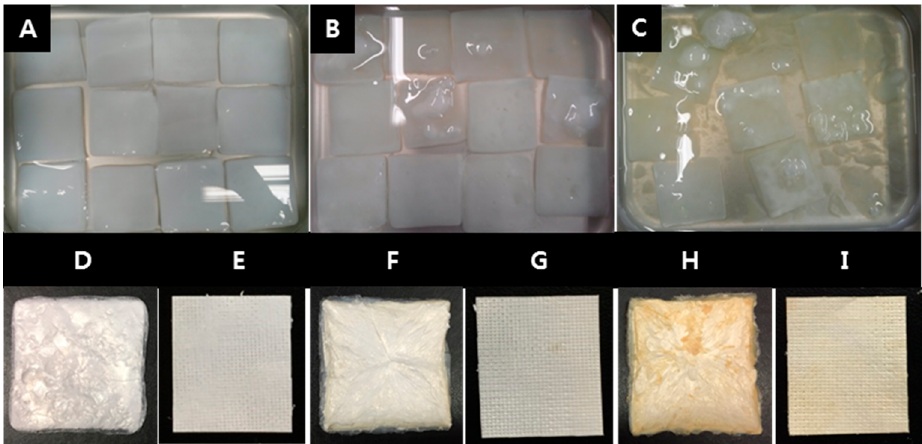
Figure 14. Bacterial cellulose (BC) pellicles were irradiated in distilled water by Electron beam linear accelerator ( A : NI-BCMs, B : 100k EI-BCMs, C : 300k EI-BCMs). After the radiation, the BC pellicles were lyophilized ( D : NI-BCMs, F : 100k EI-BCMs, H : 300k EI-BCMs) and then compressed into sheet ( E : NI-BCMs, G : 100k EI-BCMs, I : 300k EI-BCMs).